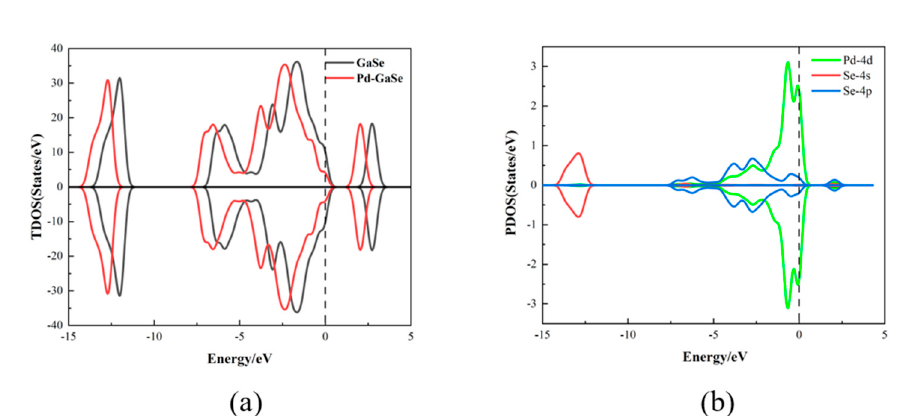
Figure 4. ( a ) TDOS of GaSe monolayer, Pd-GaSe monolayer, ( b ) PDOS of Pd-GaSe monolayer.